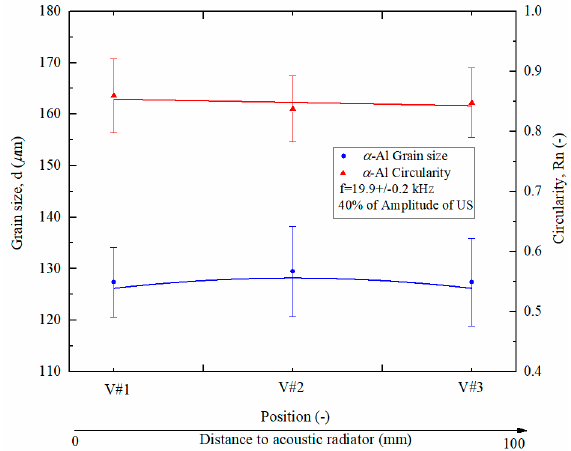
Figure 3. Variation of the α -Al grain size and circularity with the distance to the acoustic radiator in the feeder.